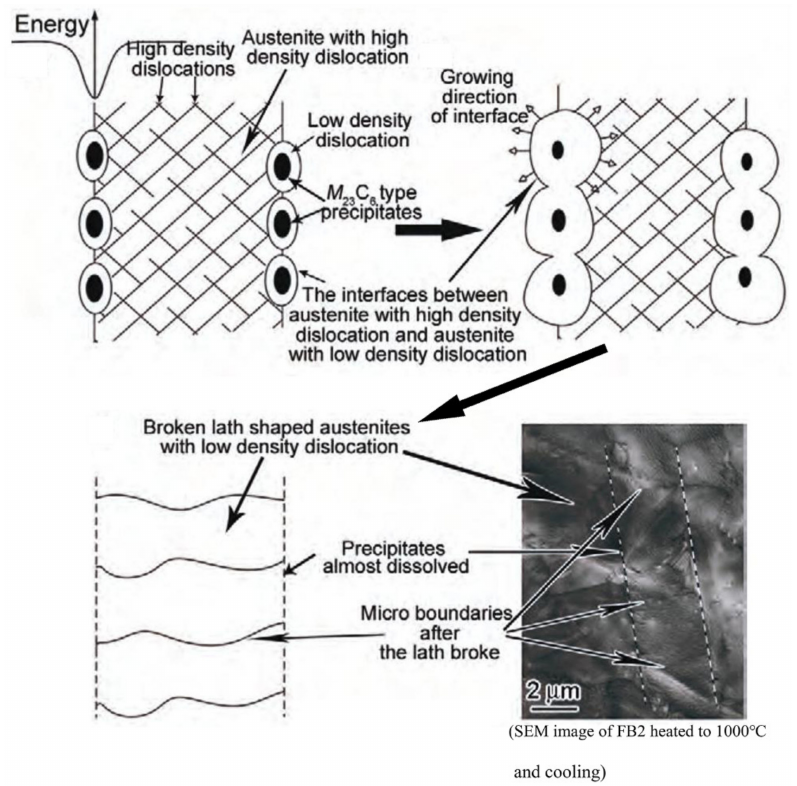
Figure 13. Schematic diagram of microstructure evolution of FB2 steel under the higher peak temperature than A C 3 or the longer holding time at peak temperature than 0.5 s